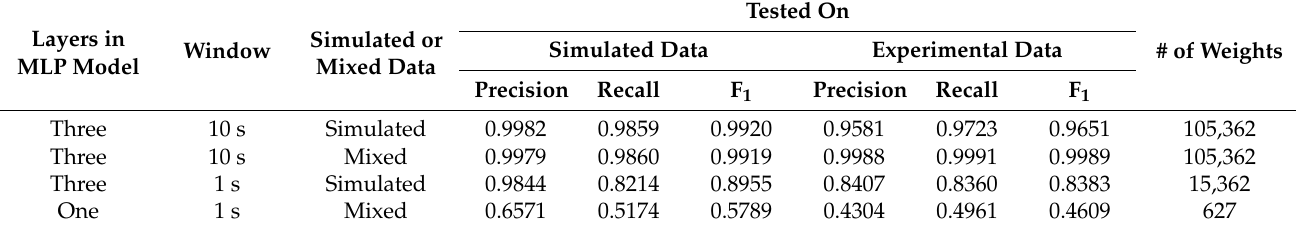
Table 4. Performance metrics for classification of 4 system states by different NN architectures.